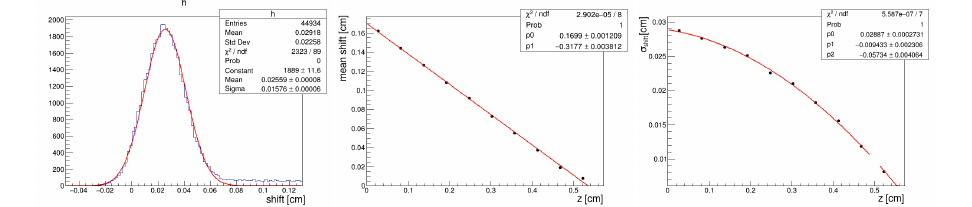
Figure 3: Left: distribution of the position shift, once an electron drifts in the transfer gap, is shown. Superimposed is the Gaussian fit used to measure the mean value and the sigma. Center and right: the motion of the electrons in the drift gap has been evaluated in these figures. The position distribution on the first GEM has been evaluated for electrons generated at several distances from the cathode. The drift gap has been divided in ten slices and each one of them a distribution has been fitted with a Gaussian. The mean value of the Gaussian functions as a function of the position in the drift gap is shown in the center; while the sigma of these distributions is shown in the right figure. The three plots have been evaluated with 1 T magnetic